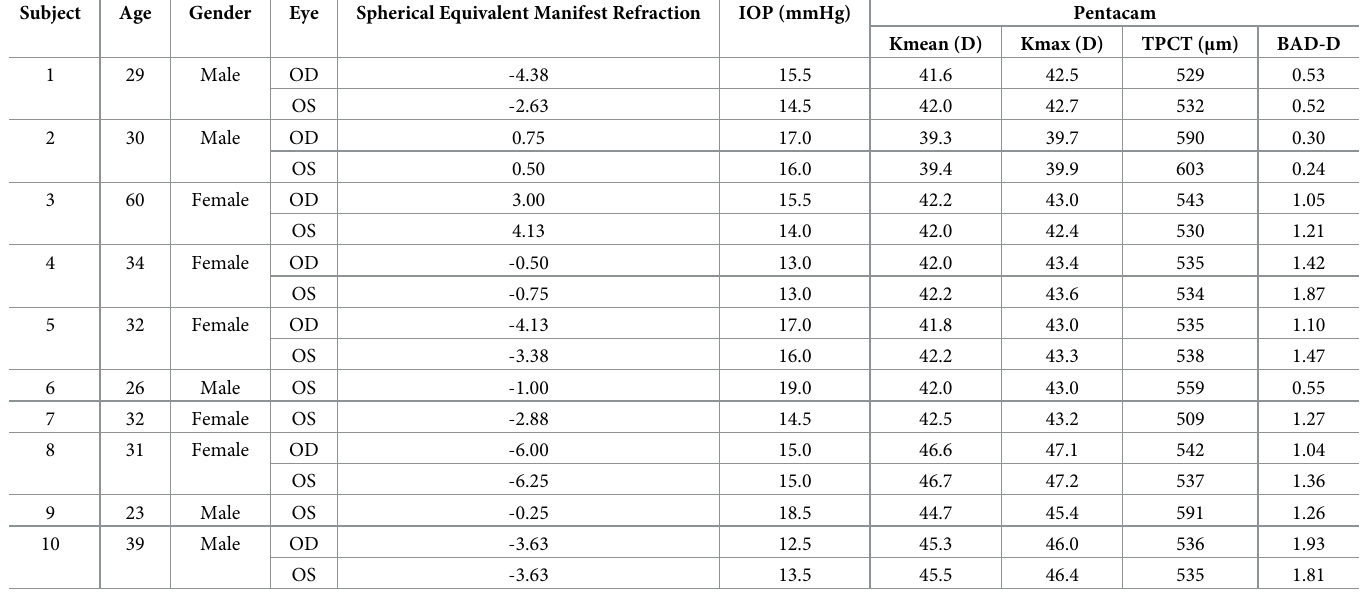
Table 1. Demographic and tomographic data for each subject.